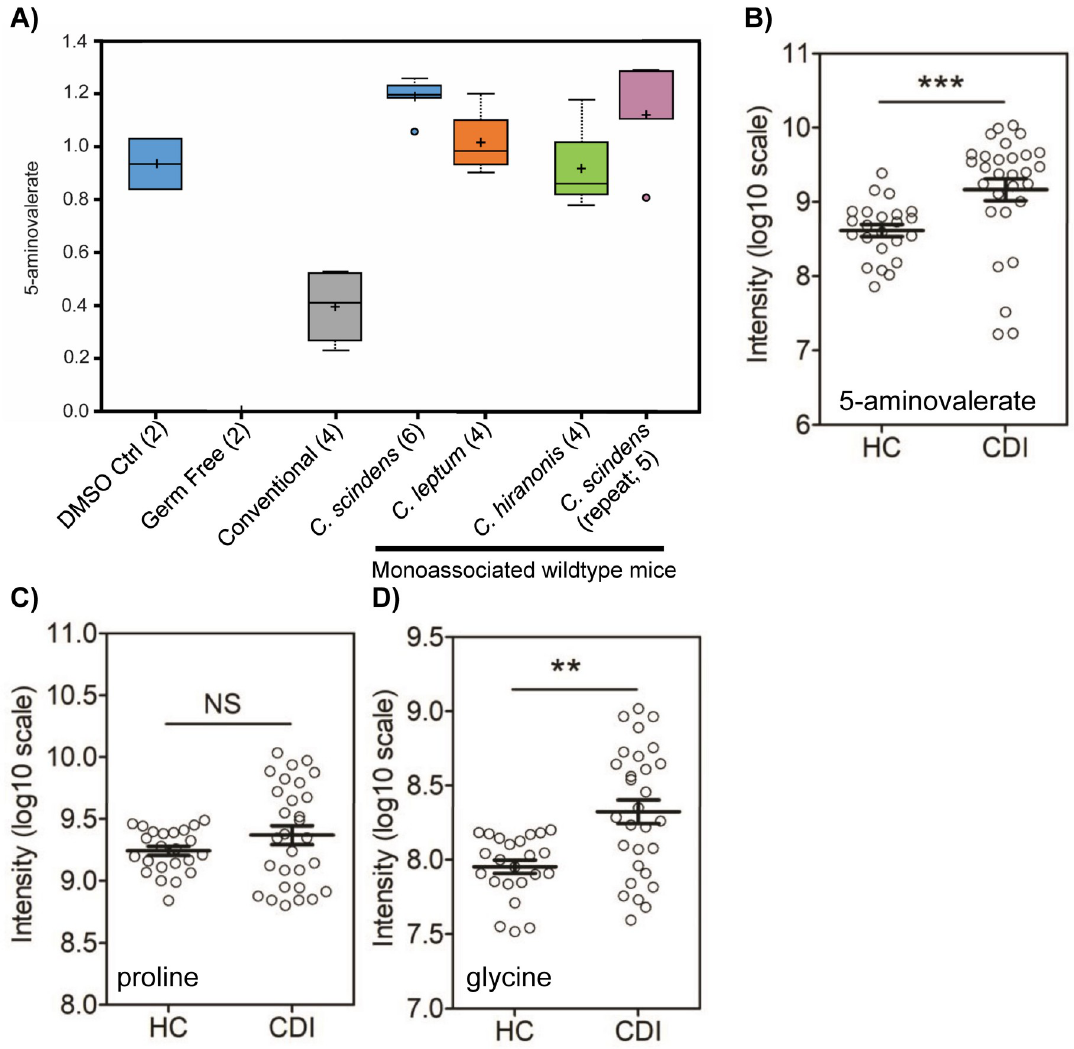
Fig 7. Untargeted metabolomics implicates Stickland metabolism / metabolites in colonization resistance. A) Cecal contents from the indicated mouse samples (number of samples in parentheses) were sent for untargeted metabolomics. The abundance of 5-aminovalerate (B), proline (C) and glycine (D) in human stools samples derived from hospitalized controls (HC; N = 23) and CDI positive patients (N = 29) is quantified. Two-tailed Mann-Whitney test was used for group comparison: NS, not significant; �� p < 0.01; ��� p <